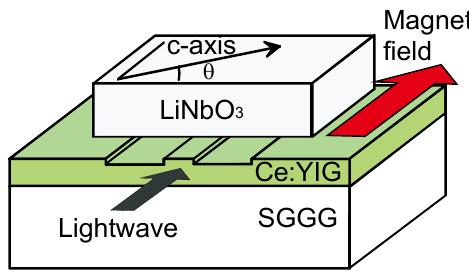
Figure 8. Schematic drawing of a semileaky waveguide optical isolator composed of a Ce:YIG guiding layer with a directly bonded LiNbO